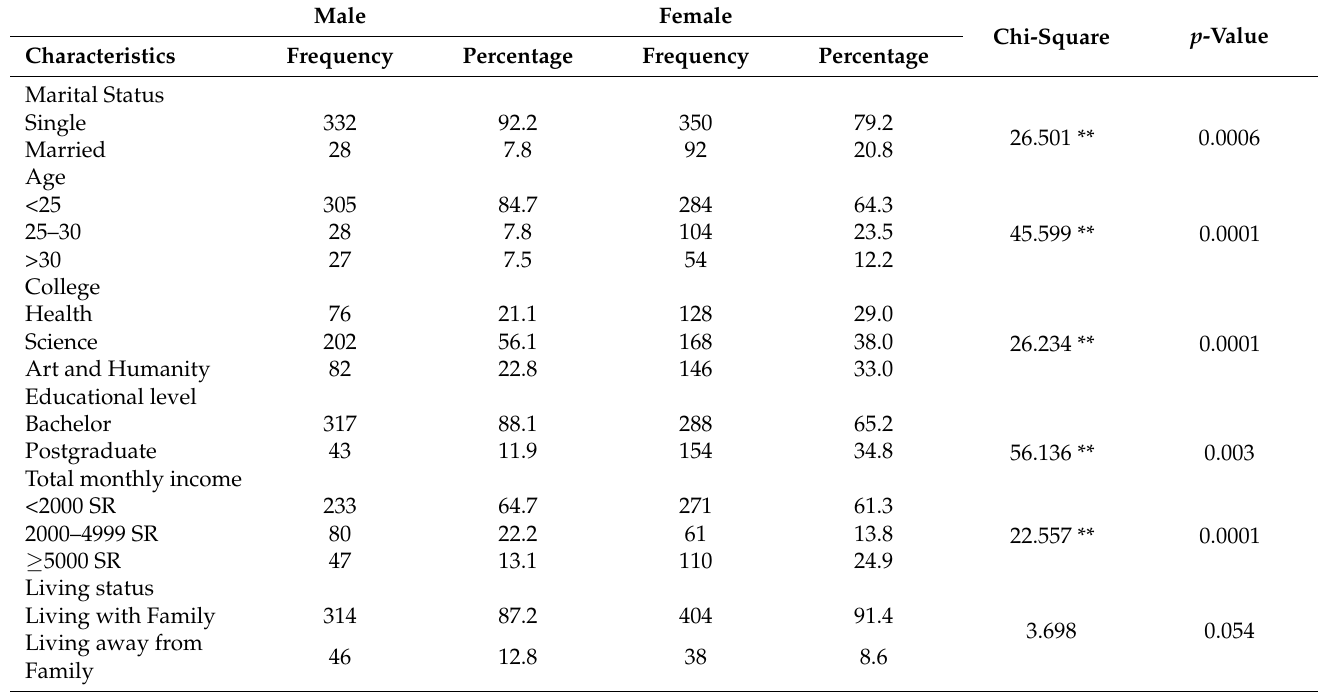
Table 1. Frequent distribution of Male ( n = 360) and Female ( n = 442) respondents by demographic and social characteristics.